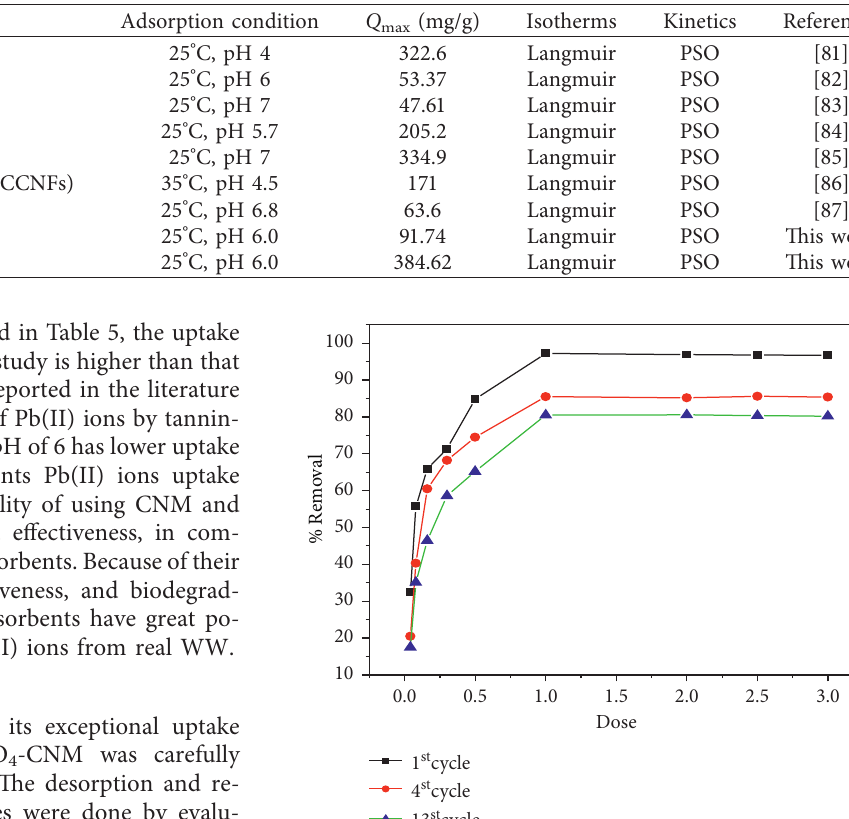
Figure 9: Adsorption mechanism of Pb(II) ions removal by CNMs. Table 5: Comparison of adsorption capacity of Pb(II) ions by different adsorbents.